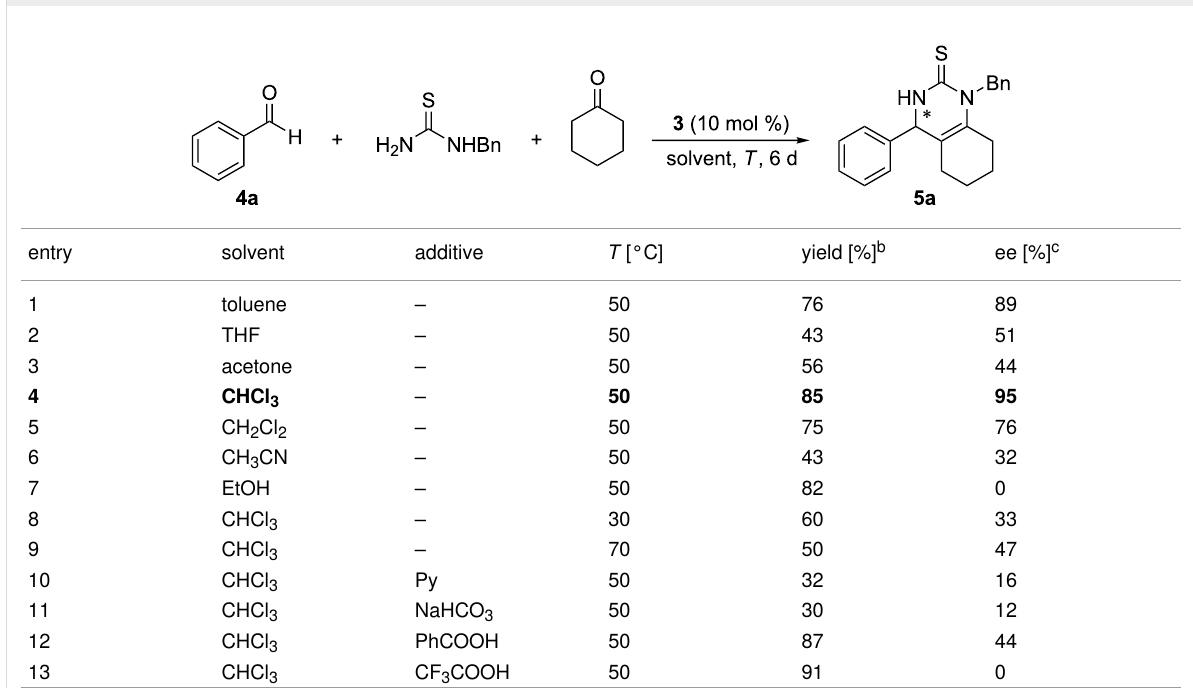
Table 1: Optimization of reaction conditions a .